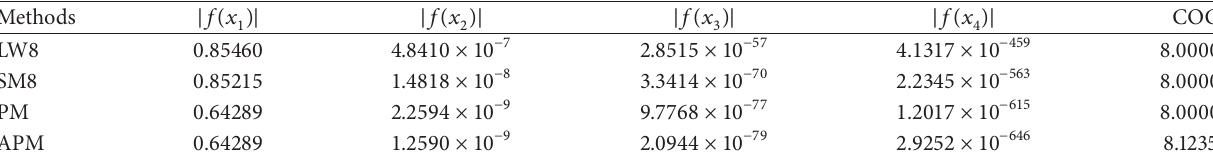
Table 1: Results of comparisons for Example 7.